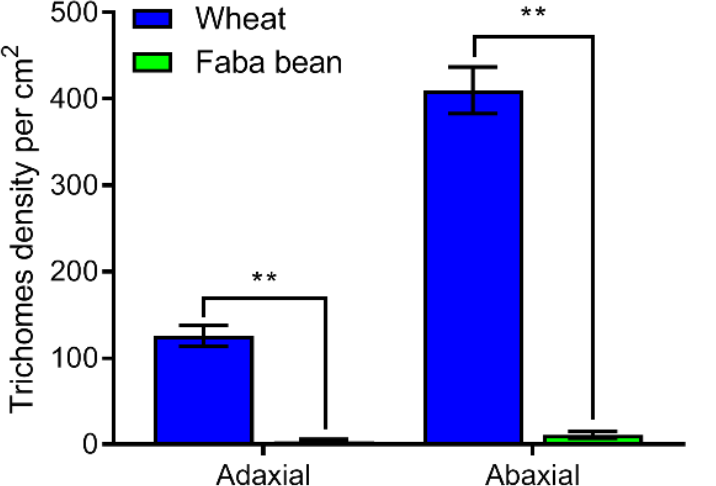
Figure 7. The trichome density (per cm 2 ) of wheat and faba bean leaves. All data are presented as the mean ± standard error (SE). “**” on the top of standard error bars indicate a significant difference between two host species (independent sample t -tests, p <